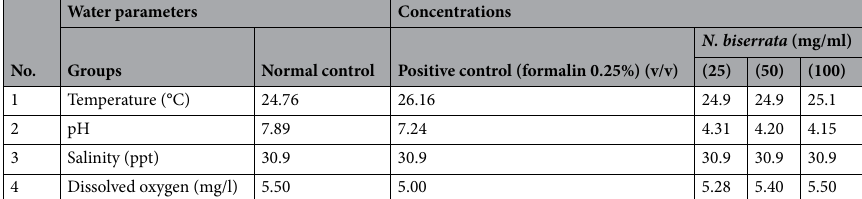
Table 3. Water quality parameters of the solutions for the treatment of